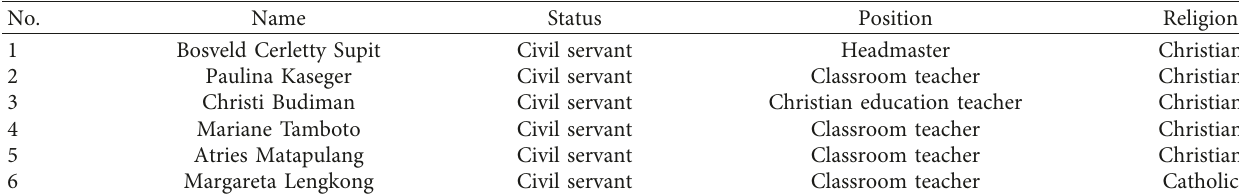
Table 4: Data for north Suwaan Minahasa State Elementary School educators.